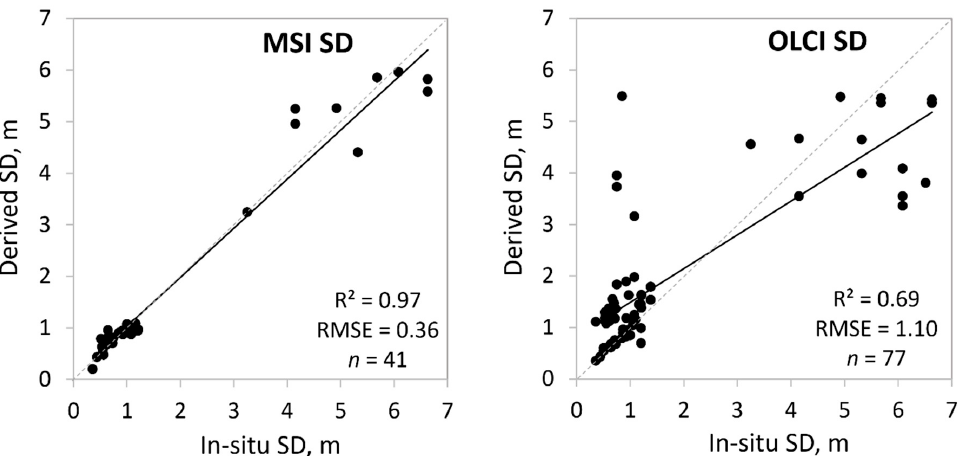
Figure 9. Correlation between in-situ and satellite derived Secchi depth (SD in m) based on the optical water types (OWTs). Also, R 2 , RMSE, and the number of samples ( n ) are given. Table 6. The best MSI and OLCI band ratios and their R 2 and RMSE for Secchi depth (SD) based on the optical water types (OWTs).